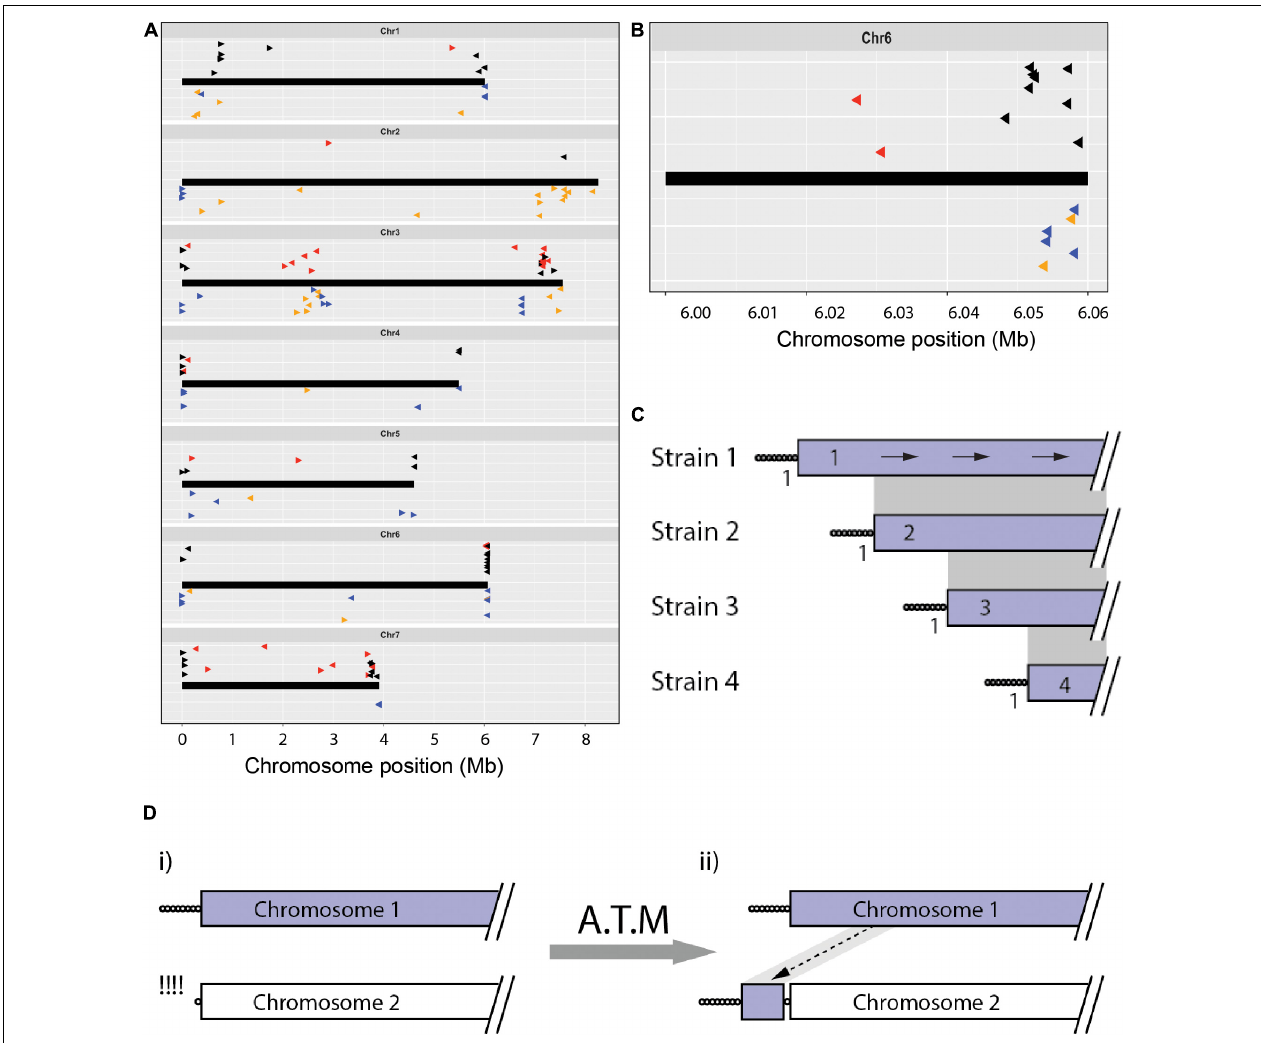
FIGURE 2 | The chromosomal geography of TAS and interstitial telomeres. (A) Plots showing the “normal” chromosomal locations of sequences that were found in telomere-adjacent positions in one or more isolates. Chromosomes are represented as thick black lines. Data points plotted on top show the positions on the CD156 chromosomes of sequences occupying telomere-adjacent positions in the Pyricularia strains used in TJ analysis (The arrowheads point 5 (cid:48) to 3 (cid:48) on the telomeric query sequence - the clipped off telomere would have been at the 5 (cid:48) end of the arrow). Black arrowheads represent TAS that are single-copy in the source genome, red are duplicated TAS. The dataset was filtered to remove redundant matches where two strains shared identical TJs. Data points on the bottom ( (cid:49) ) show the relative positions of all interstitial telomere sequences found in the MinION assemblies of Arcadia2, CD156, FH, FR13, Guy11, LpKY97, U233 and US71. Tri-repeats (CCCTAA/TTAGGG) 3 + , < 4 are shown in orange and tetramers (CCCTAA/TTAGGG) ≥ 4 are shown in blue. Arrowheads pointing right represent CCCTAA repeats and left, TTAGGG. Vertical “jittering” was used to improve the resolution between matches at similar positions. (B) TAS alignments on the right-hand end of chromosome 6 showing an organization consistent with progressive chromosome truncations. (C) Schematic showing how truncations differentially affect the preservation of TJs and TAS. Depicted are alignments of a single chromosome end that is variably truncated in four strains. Telomere repeats are represented as circles and gray shading connects subterminal sequences that align. Numbers adjacent to the TJs indicate the number of strains that share each junction; and values in the TAS show the numbers of strains containing that TAS. The arrows on the top chromosome show how blast searches with TAS from strains 2, 3, and 4 TAS are expected to produce alignments with identical orientations. (D) Schematic showing copying of internal chromosome sequence onto a failed telomere. (i) Chromosome 2 experienced failure and resection of the telomere; (ii) the free end was then repaired via an ATM process that resulted in the copying of internal sequence from chromosome 1 onto the free